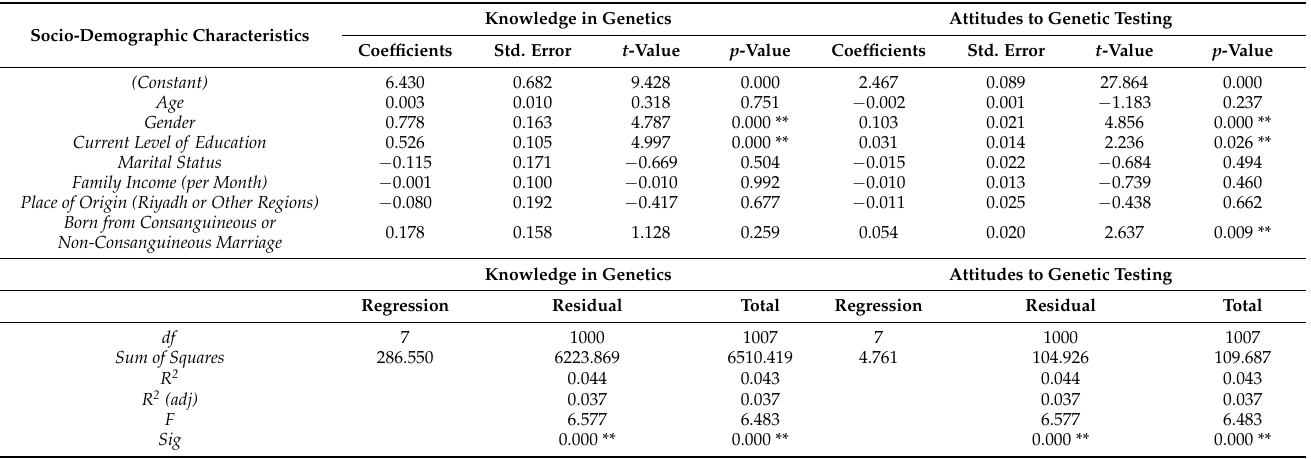
Table 5. Multiple Regression Results between the Sociodemographic Characteristics of the Respon- dents and their Knowledge of Genetics and Attitudes to Genetic